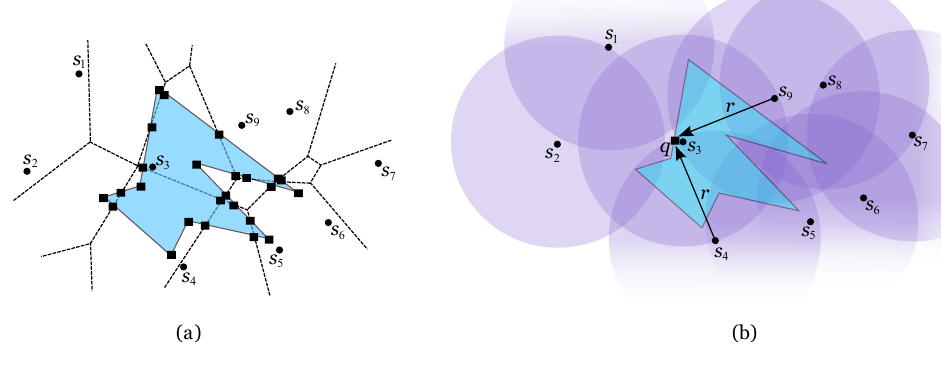
Figure 6. (a) The candidates are represented by squares: vertices of R , points of B ( R ) ∩ VD ( S ) and a vertex of VD 2